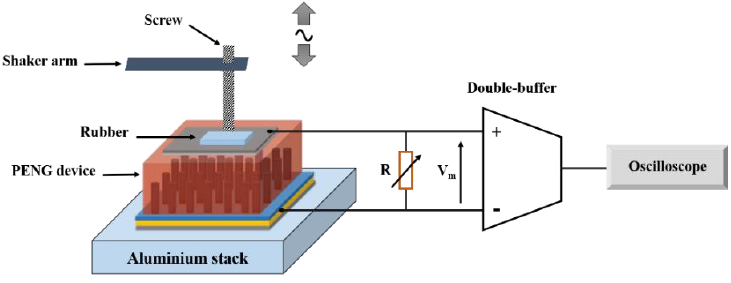
Figure 5 . Test bench for PENG performance measurement.